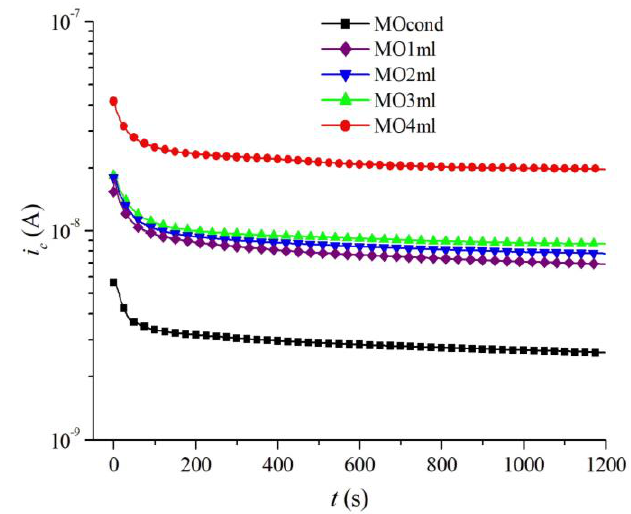
Figure 8. The variation of the conduction current against time ( U 0 = 200 V and T = 24 °C).